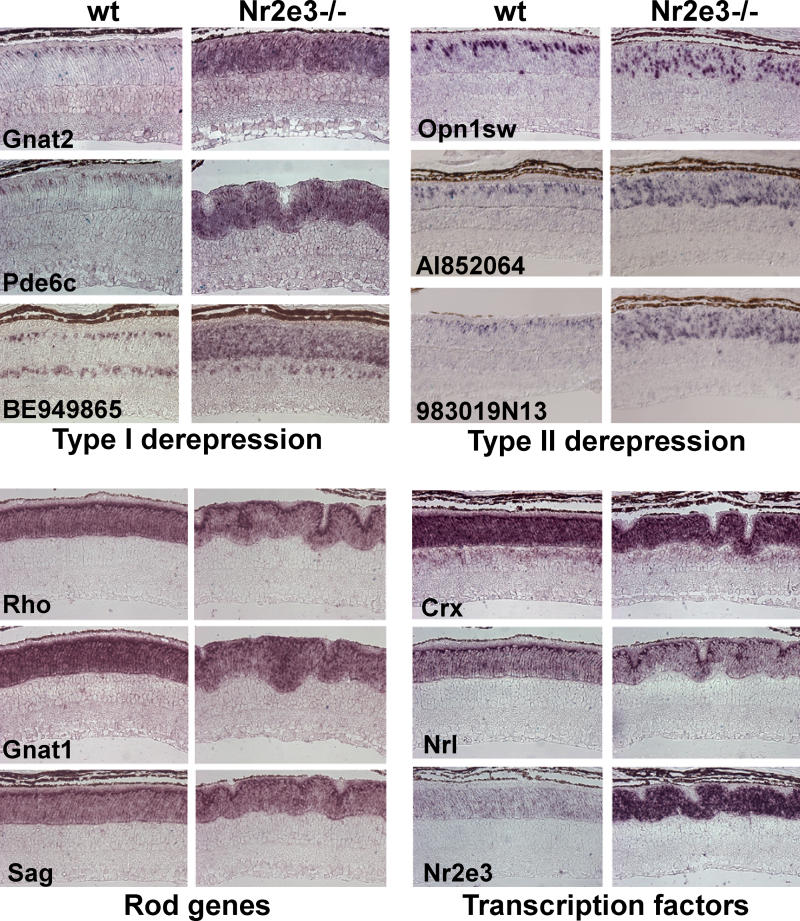
Cone and Rod Gene Expression in the rd7 Mutant at P14The upper sets of photomicrographs demonstrate examples of type I and type II cone gene derepression in the rd7 mutant retina as explained in the main text. The bottom left images show several rod-specific genes that are essentially unchanged in the rd7 background at P14. The bottom right images show the expression pattern of three photoreceptor transcription factors in the rd7 mutant. Abbreviations in the lower left hand corner of each pair of panels represent the gene symbols summarized in Figure 1.